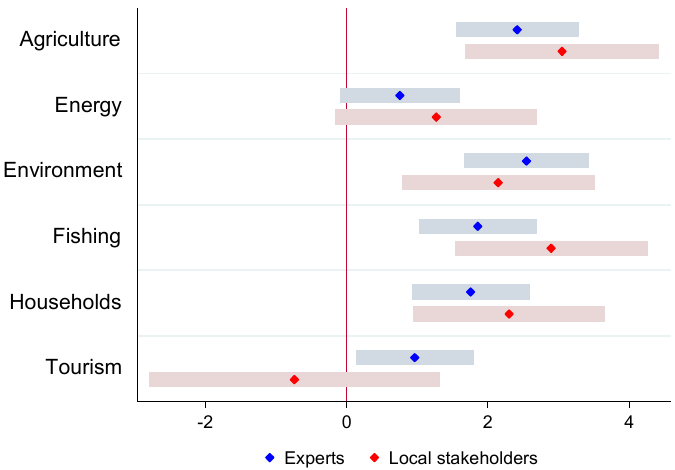
Figure 3. Points and confidence interval at 90% for coefficients estimated using a logistic regression analysis. The dependent variable is equal to 1 if the respondent considers that the proposed sector is strongly relevant (the reference sector is industry). The independent variables are dummy variables per proposed sectors. The logistic regressions are estimated separately for the expert subsample (in blue) and for the local stakeholder subsample (in red).